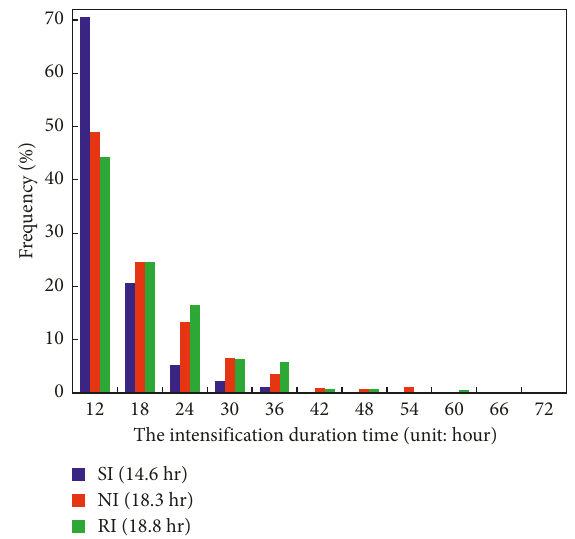
Figure 6: The frequency distribution of the intensification duration time of the three intensification categories (RI, NI, and SI) for